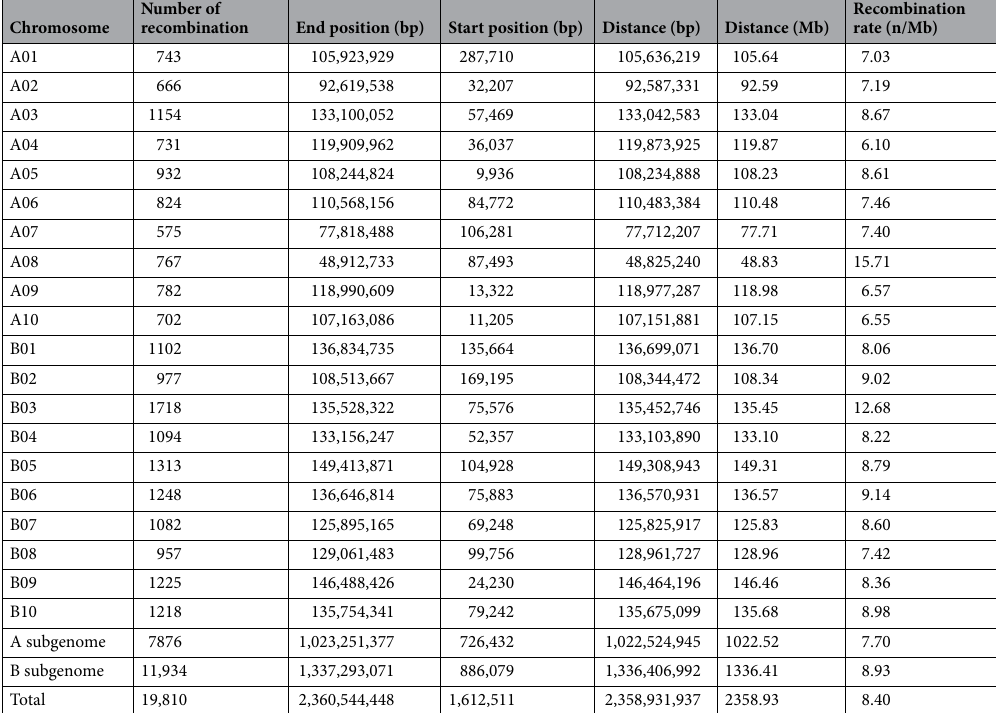
Table 2. Number of recombination, star position, end position, physical distance and recombination rates in each chromosome of the peanut 49